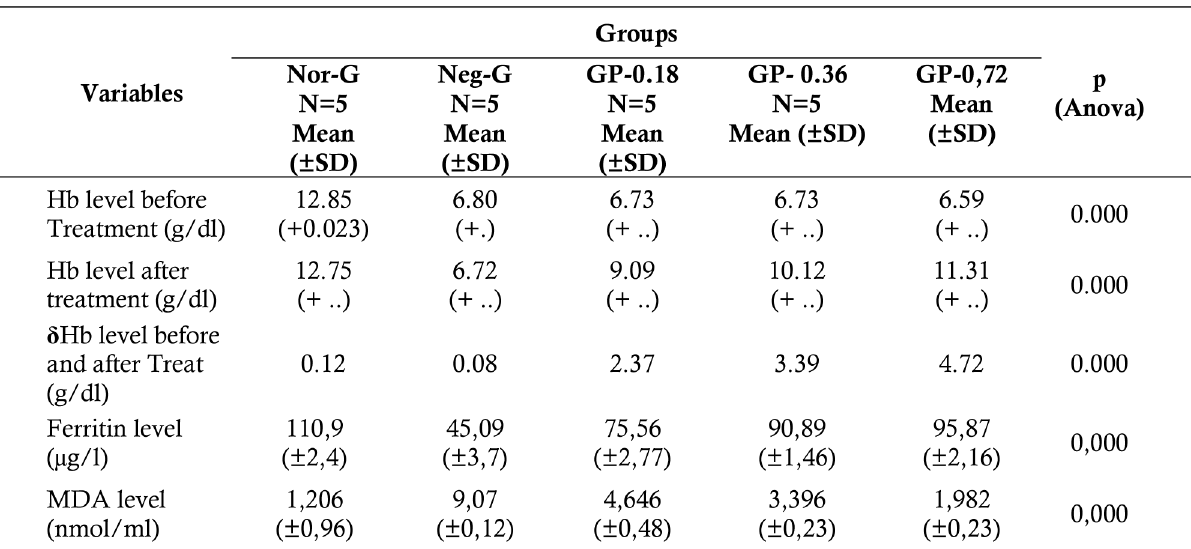
Table 1. Mean of Hb, Ferritin, and MDA Levels on each